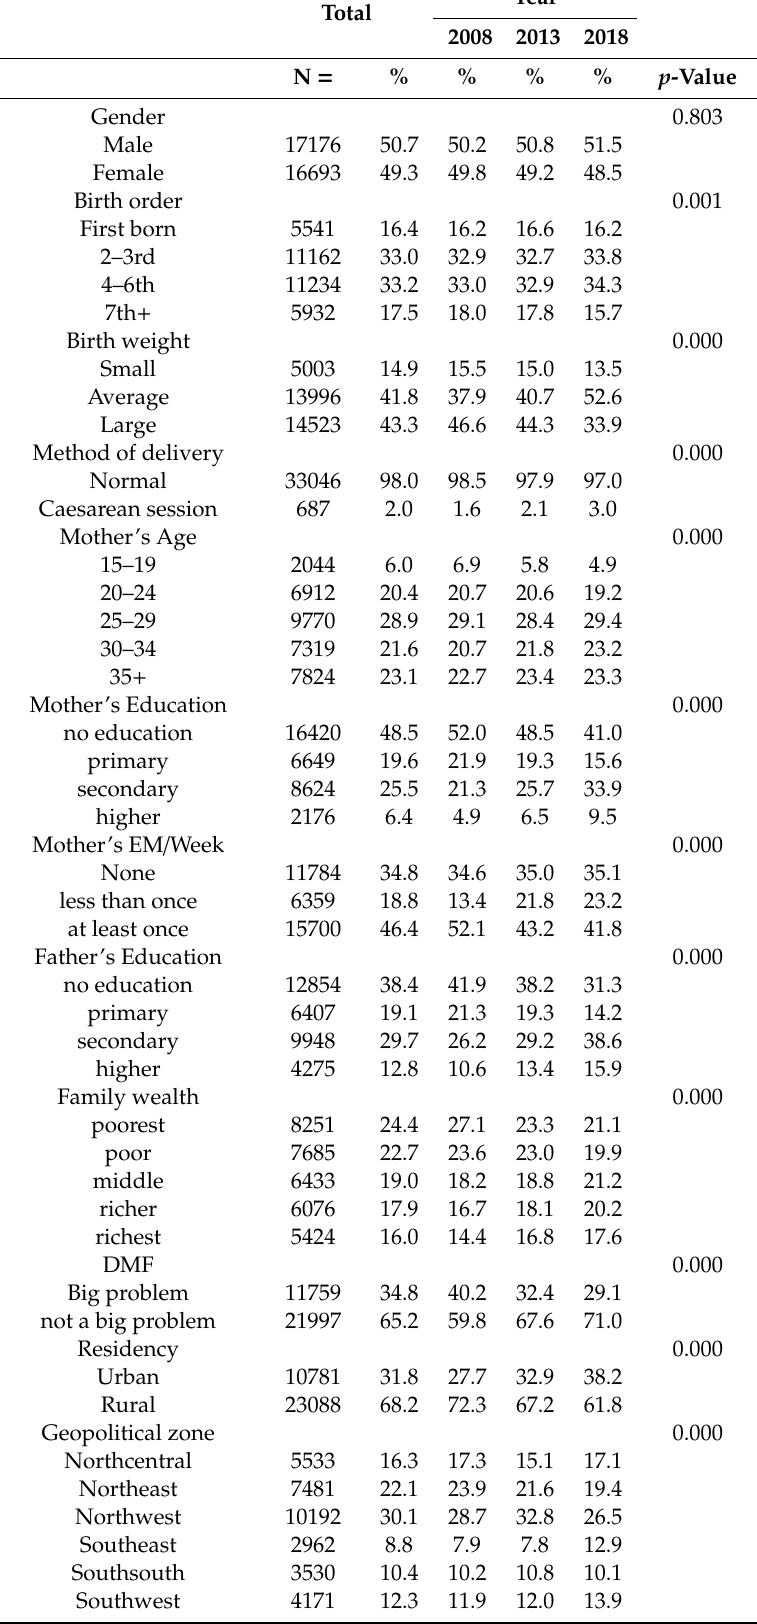
Table 1. Distribution of Observation Meeting Main Selection Criteria, Followed up by Year of